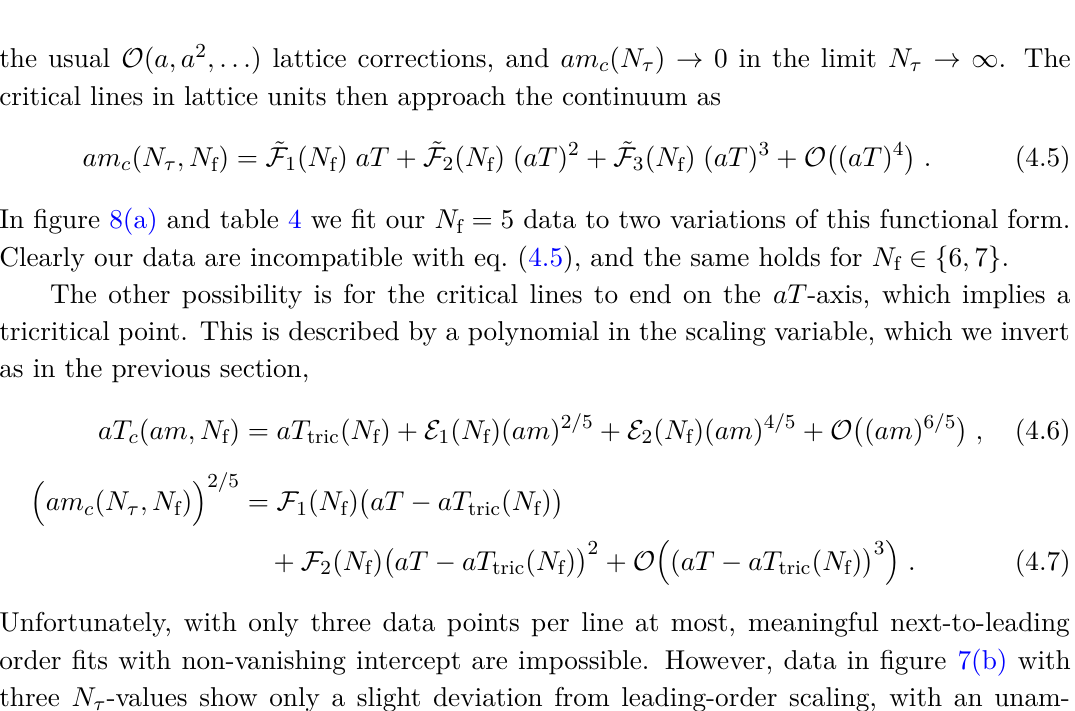
Table 4. Fits of the critical lines in figure 8(a) to eq.